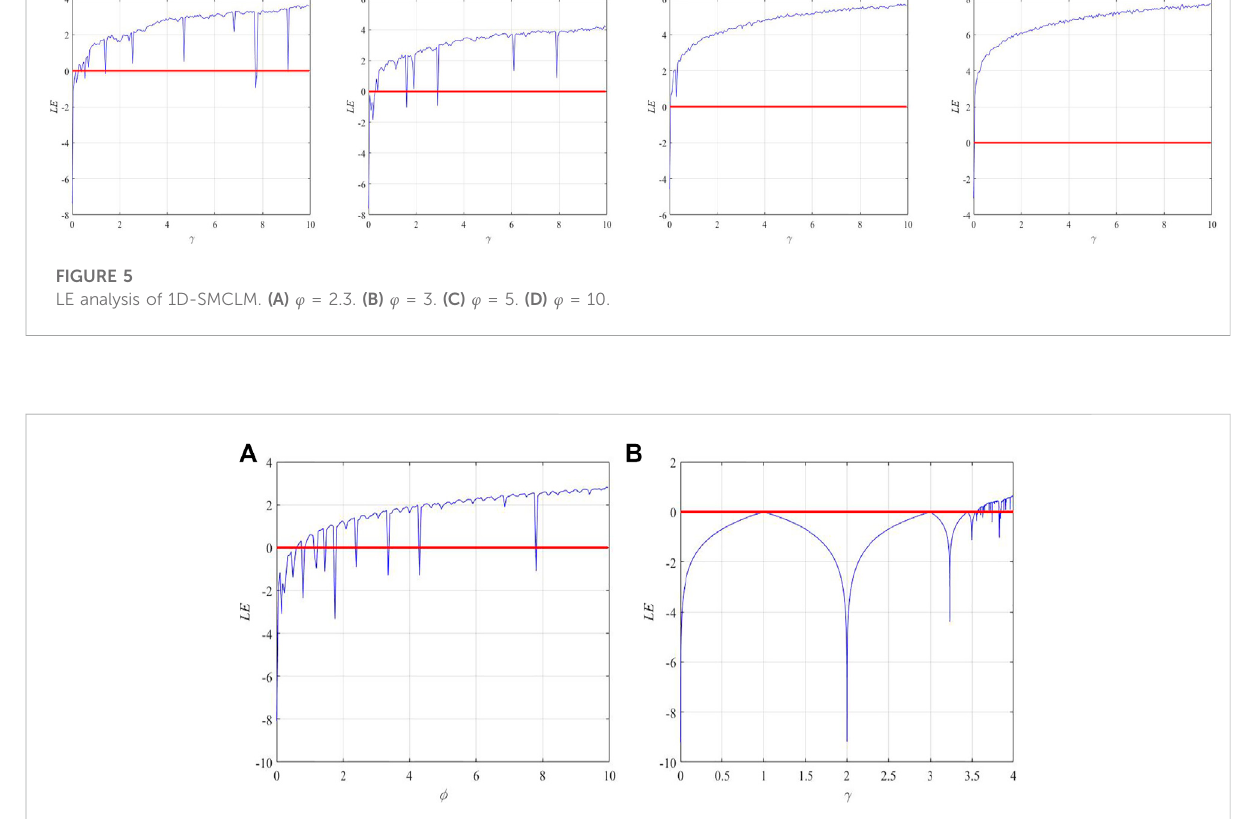
FIGURE 6 LE analysis of Sin Map and Logistic Map. (A) LE of Sin Map. (B) LE of Logistic